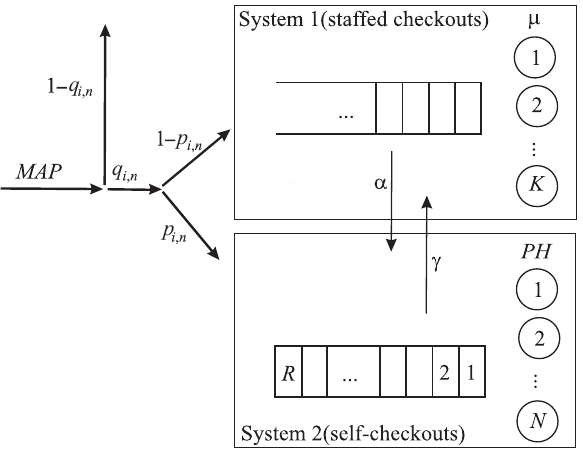
Figure 1. Structure of the